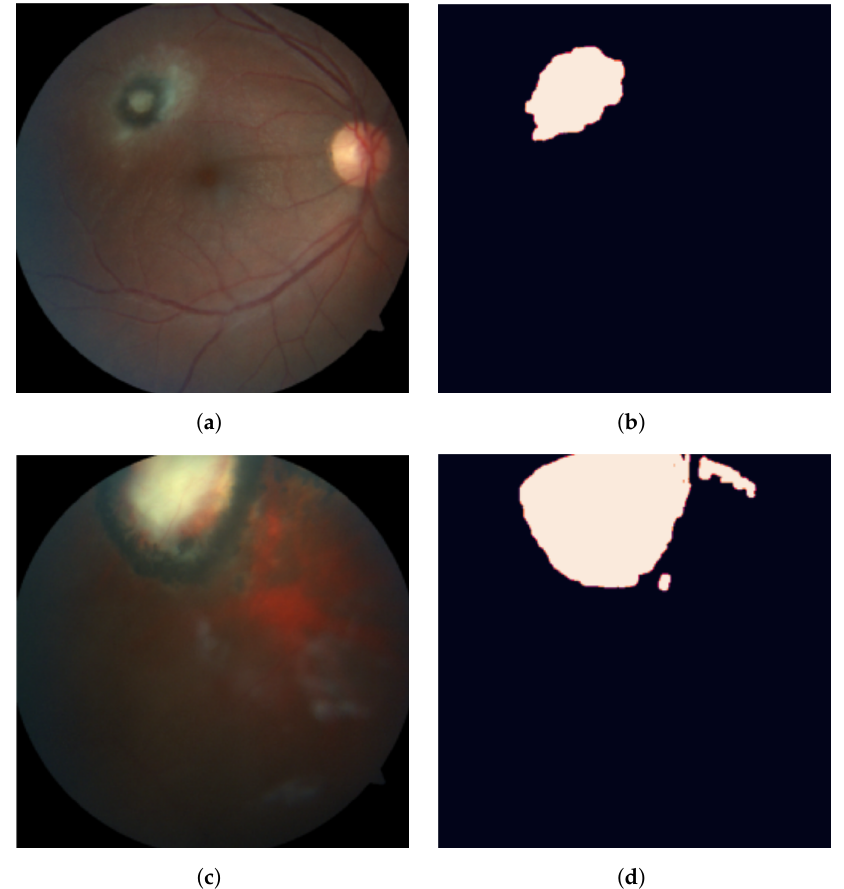
Figure 2. A sample of unhealthy eye fundus images ( a , c ) with their corresponding masks of seg- mented OT lesions ( b , d ) from the